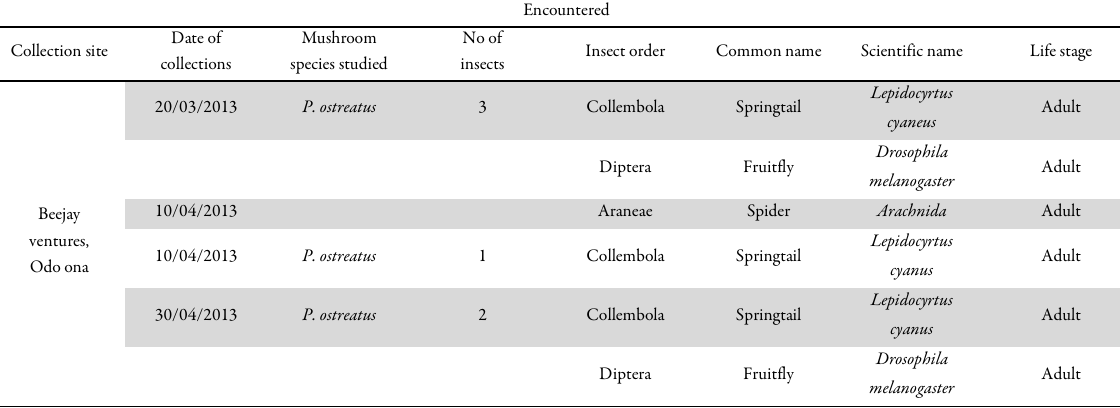
Table 2. Number of insect orders encountered on cultured mushroom (Pleurotus ostreatus)